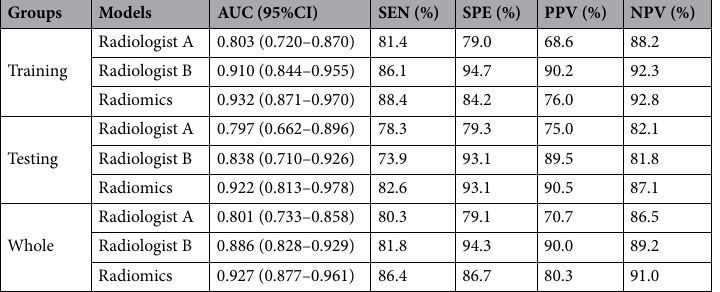
Table 3. Diagnostic performances of radiomics model and PI-RADS v2.1 score by two radiologists. Note. AUC, area under the curve; SEN, sensitivity; SPE, specificity; PPV, positive predictive value; NPV, negative predictive value; CI, confidence interval. The assessment of PI-RADS v2.1 was performed by two radiologists, a junior with 5 years of experience (Radiologist A) and a senior with more than 20 years of experience (Radiologist B) in urogenital imaging.